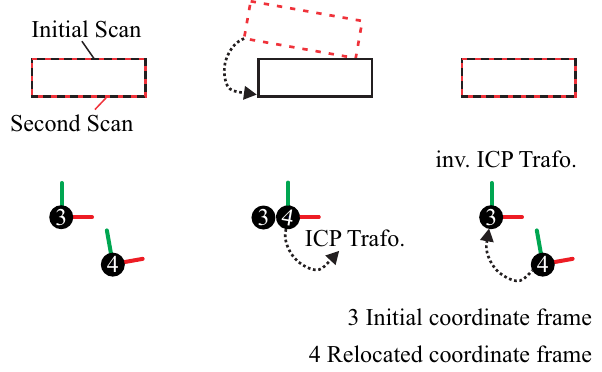
Figure 4. Utilized approach for ICP-based robot position